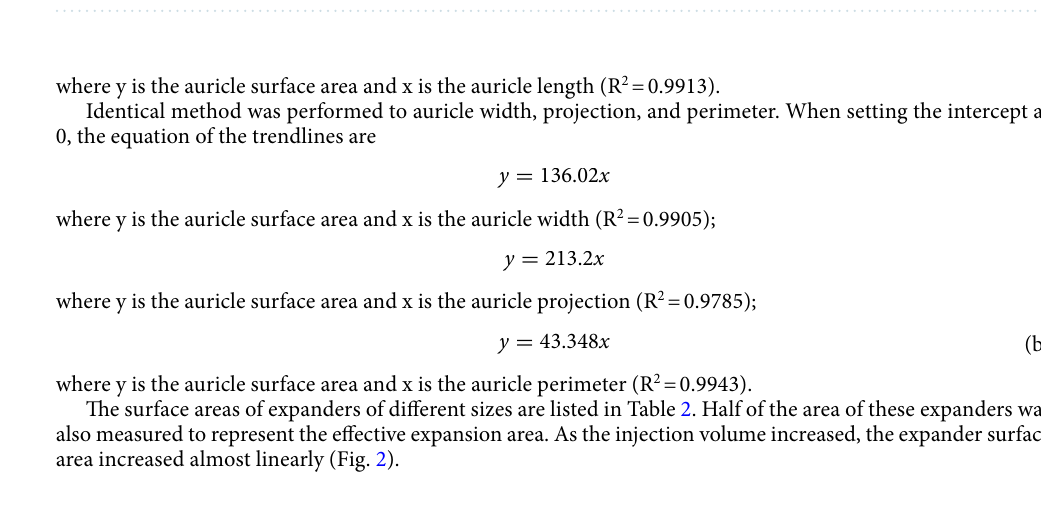
Figure 2. Relationship between expander’s injected volume and expander’s half surface